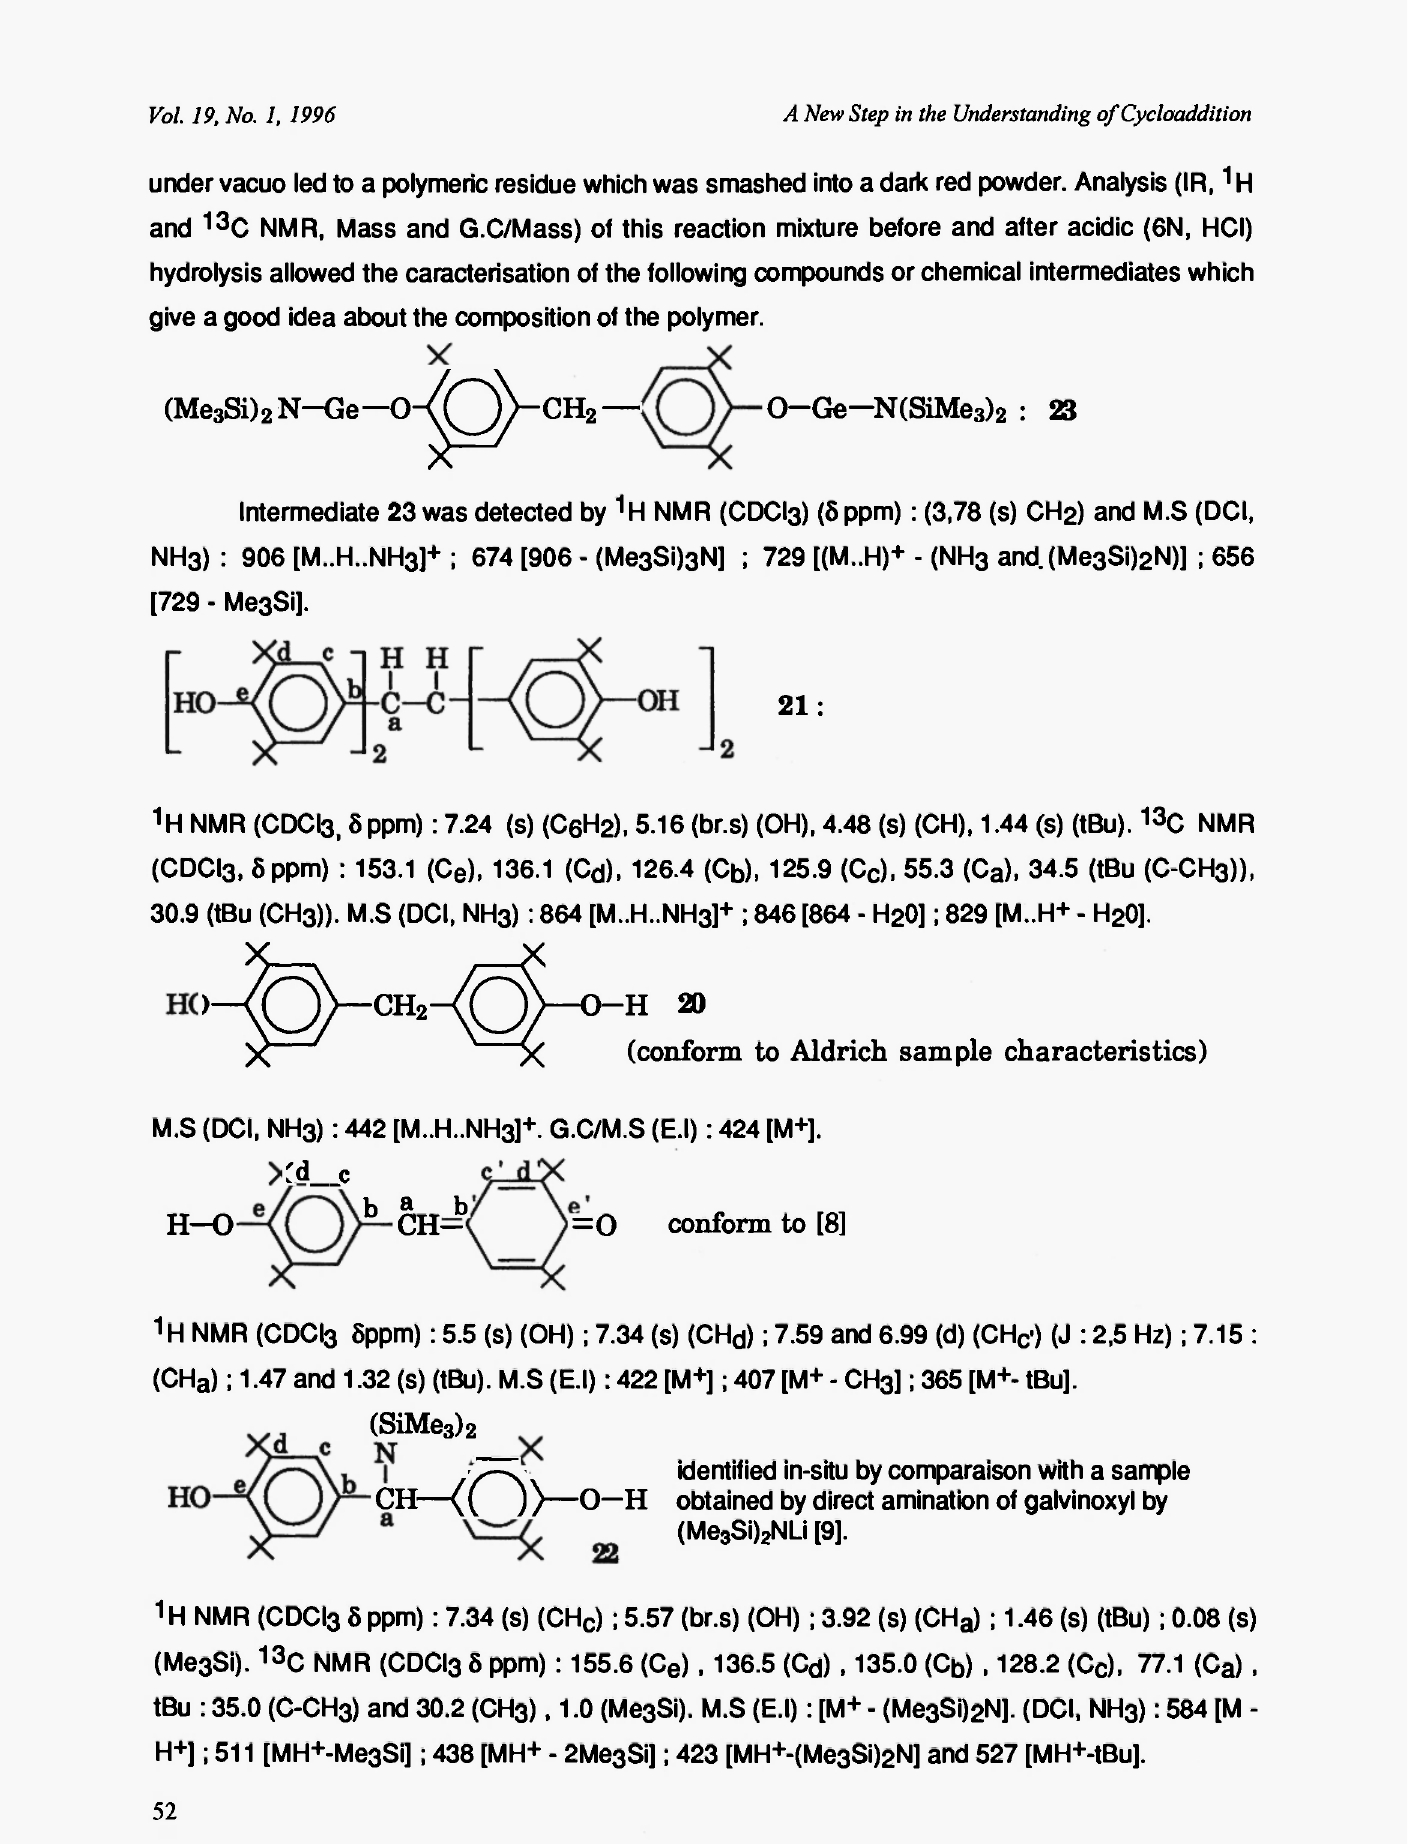
identified in-situ by comparison with a sample obtained by direct amination of galvinoxyl by (Me 3 Si) 2 NLi